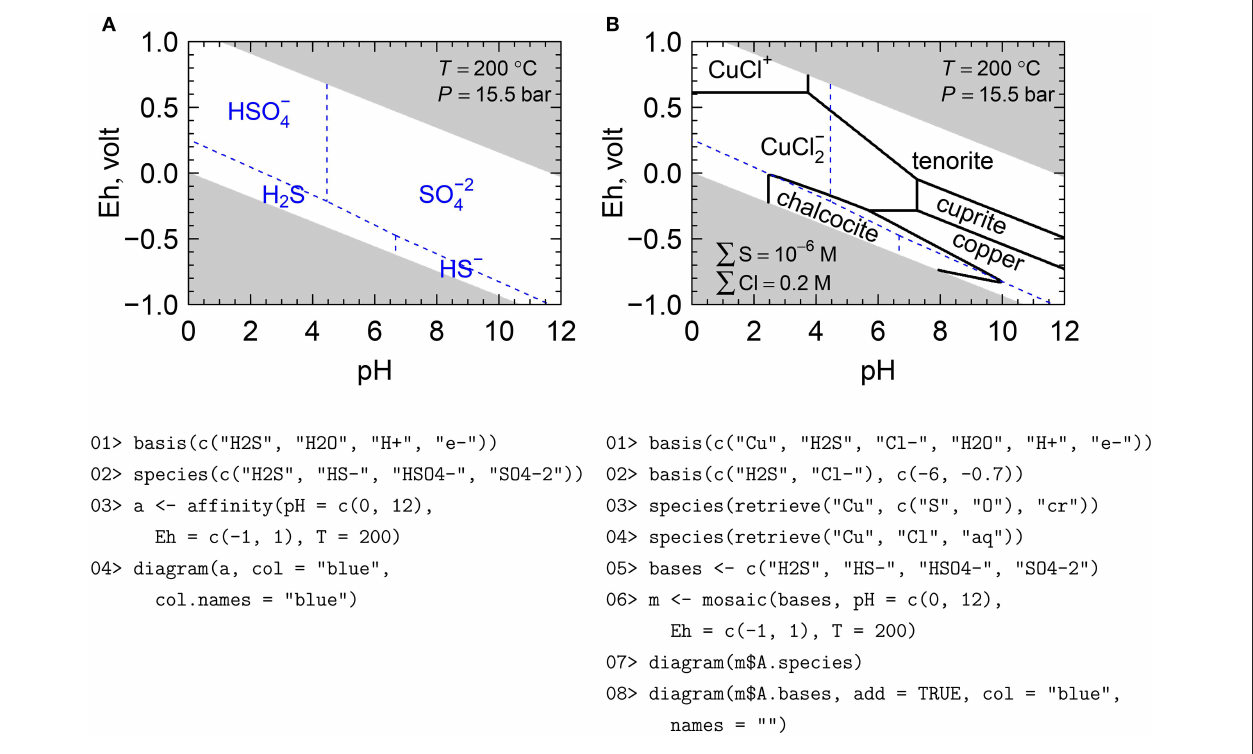
FIGURE 4 | (A) Eh-pH predominance diagram for aqueous sulfur species, and (B) mosaic diagram for Cu–S–Cl species. Shaded areas of the diagrams are outside the stability region of liquid H 2 O. Thermodynamic data for minerals are from Helgeson et al. (1978) and data for aqueous species are from Shock and Helgeson (1988) , Shock et al. (1989), and Sverjensky et al. (1997), except Cu(I) species from Akinfiev and Zotov (2001). The R script shown here is simplified for clarity; the complete script, which includes code to increase the plot resolution and to adjust the colors and labels, is available (Dick,